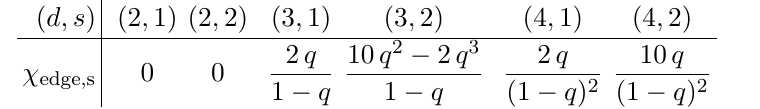
→ ( d + 2) × edge. For massless spin- s , use (5.5)–(5.7) or (G.34). The edge companions of (1.9)